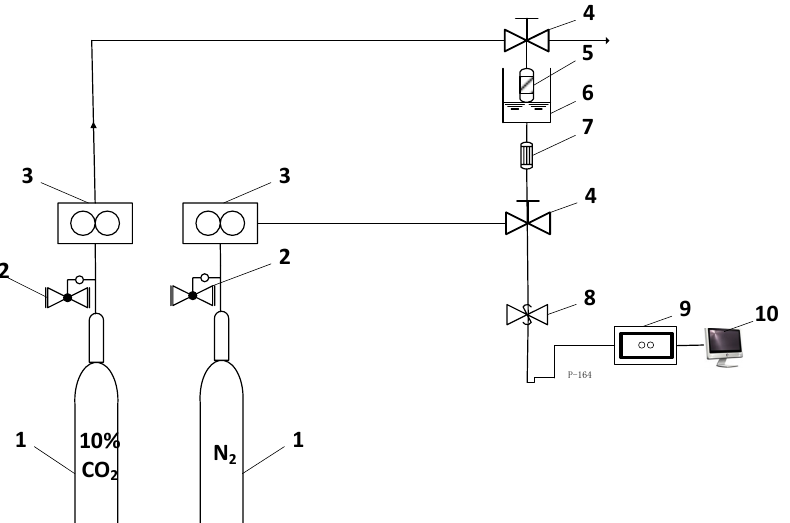
Figure 1. Apparatus for CO 2 adsorption. (1) Gas cylinder, (2) relief valve, (3) gas mass flow controllers, (4) three-way valve, (5) fixed bed reactor, (6) electrical heater, (7) filter, (8) counterbalance valve, (9) infrared gas analyser, (10) data collector.